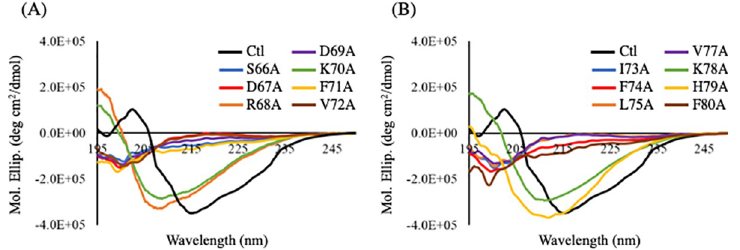
Fig 3. Far-UV CD spectra of the alanine substituents of α A66–80 (L-isoAsp76) peptides. Black line shows the far- UV CD spectrum of the control α A66–80 (L-isoAsp76: Ctl) peptide. (A) Blue, red, orange, purple, green, yellow, and brown lines show the far-UV CD spectra of S66A, D67A, R68A, D69A, K70A, F71A, and V72A substituents, respectively. (B) Blue, red, orange, purple, green, yellow, and brown lines show the far-UV CD spectra of I73A, F74A, L75A, V77A, K78A, H79A, and F80A substituents, respectively. The spectra were recorded between 195 and 250 nm. Each spectrum represents an average of five scans.